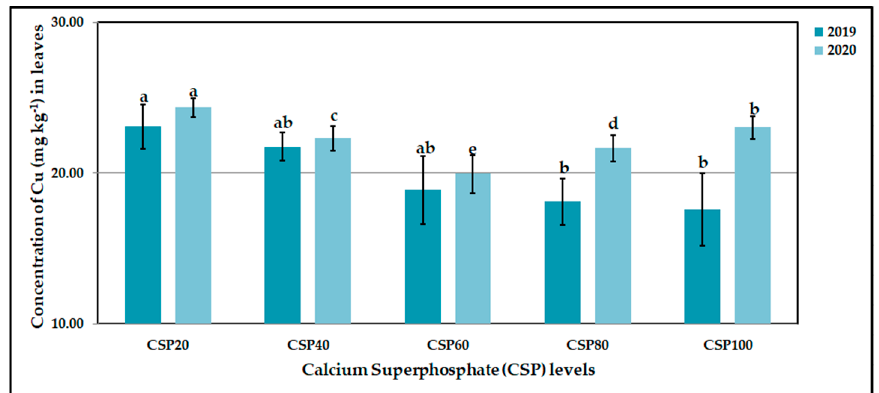
Figure 3. Influence of calcium superphosphate (CSP) levels on leaf zinc (Zn, mg kg − 1 ) contents of CaCO 3 ‐ stressed sweet potato plants in 2019 and 2020 seasons. Bars with a different letter indicate significant difference between treatments at p ≤ 0.05. CSP 20 , CSP 40 , CSP 60 , CSP 80 , and CSP 100 represent CSP added as a soil application at 69, 138, 207, 276, and 345 kg ha − 1 , respectively.